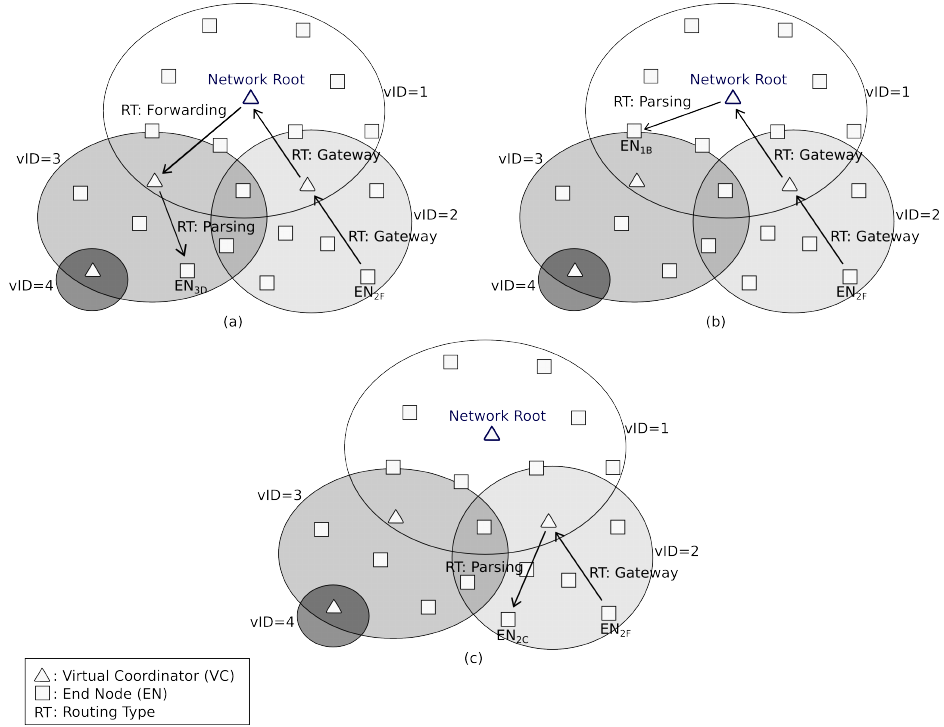
Figure 10. Example of different routing types in DARAL : ( a,b ) inter-cluster communication; and ( c ) intra-cluster